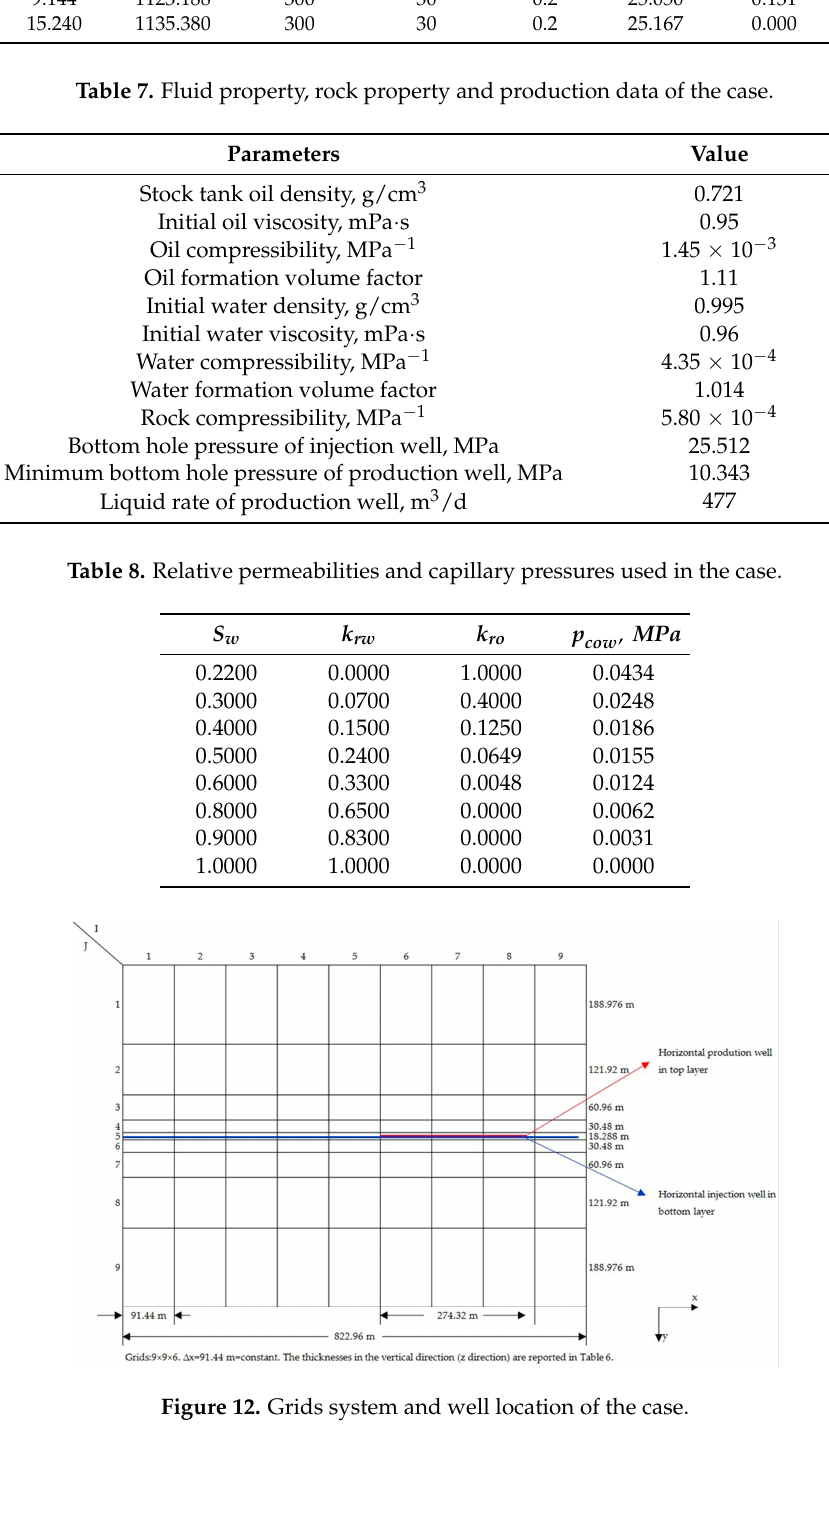
Table 6. Reservoir data and initial conditions of the case used to validate the designed simulator. Table 7. Fluid property, rock property and production data of the case.